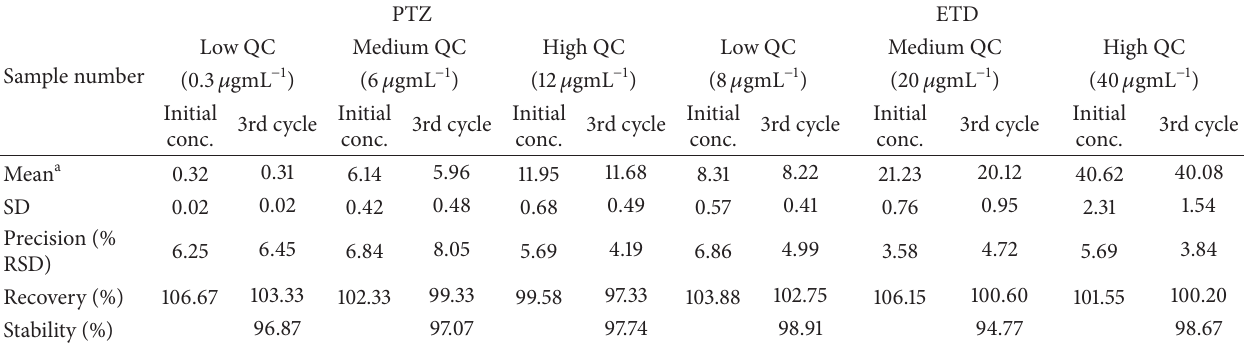
Table 4: Data of freeze-thaw stability of ETD and PTZ plasma samples for QC samples.